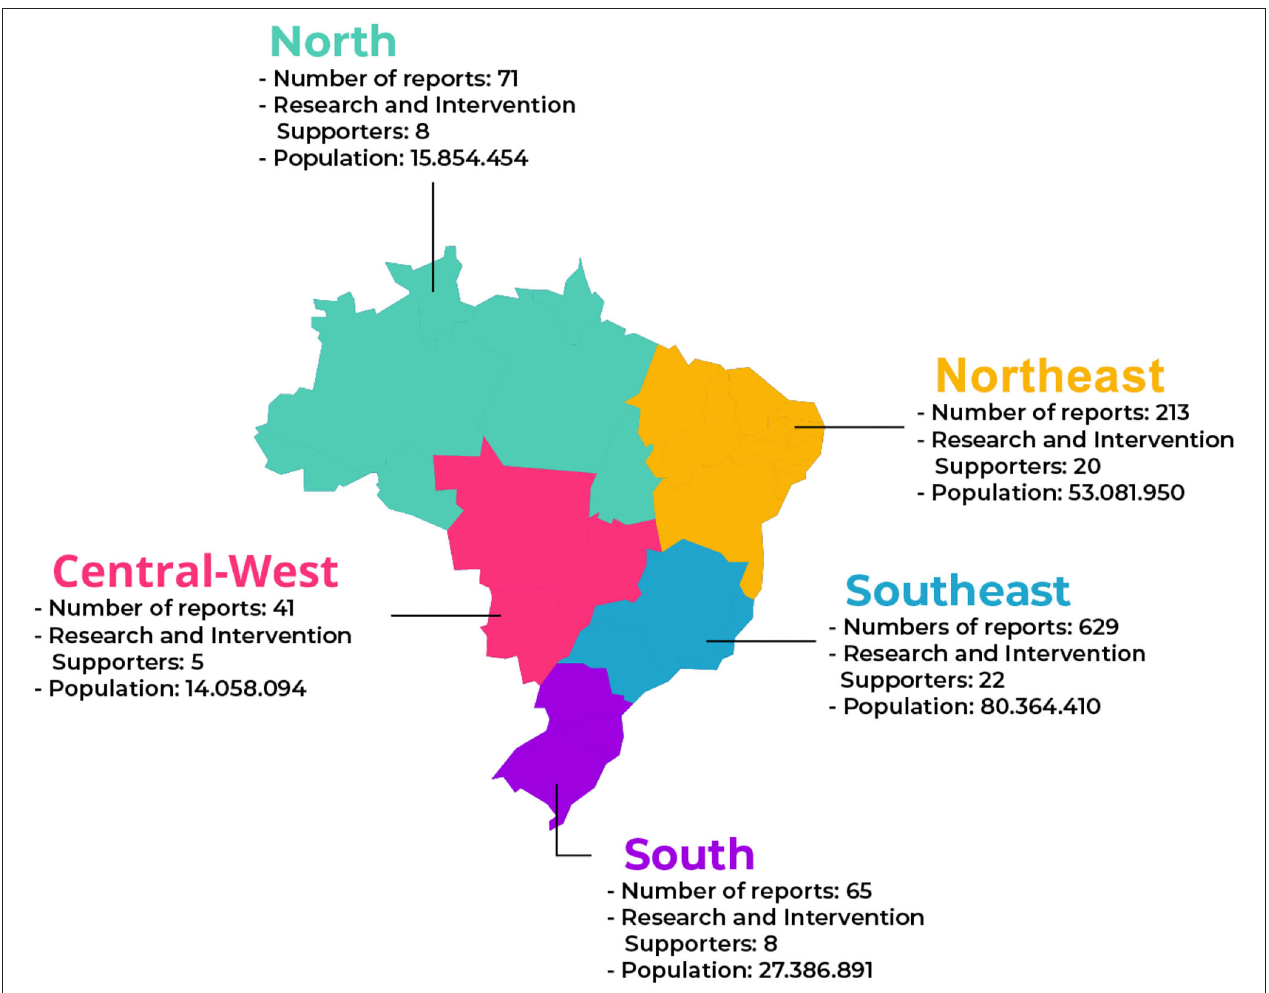
FIGURE 4 | Map of Brazil with general information about the reports